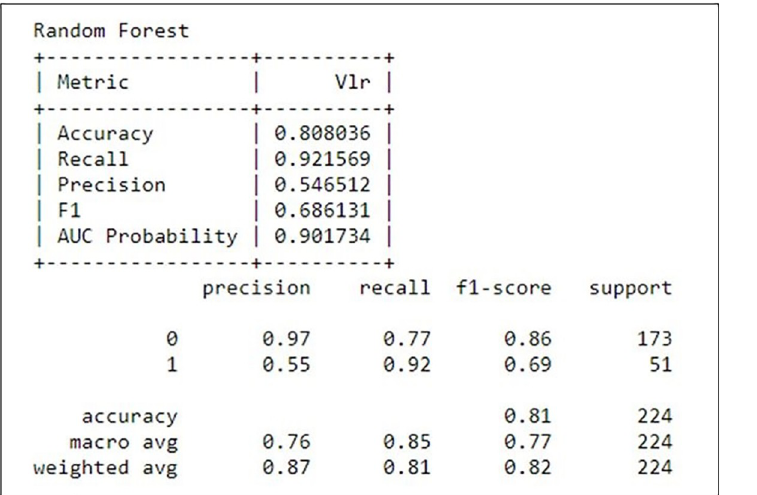
Fig 4. Performance metrics of the RF